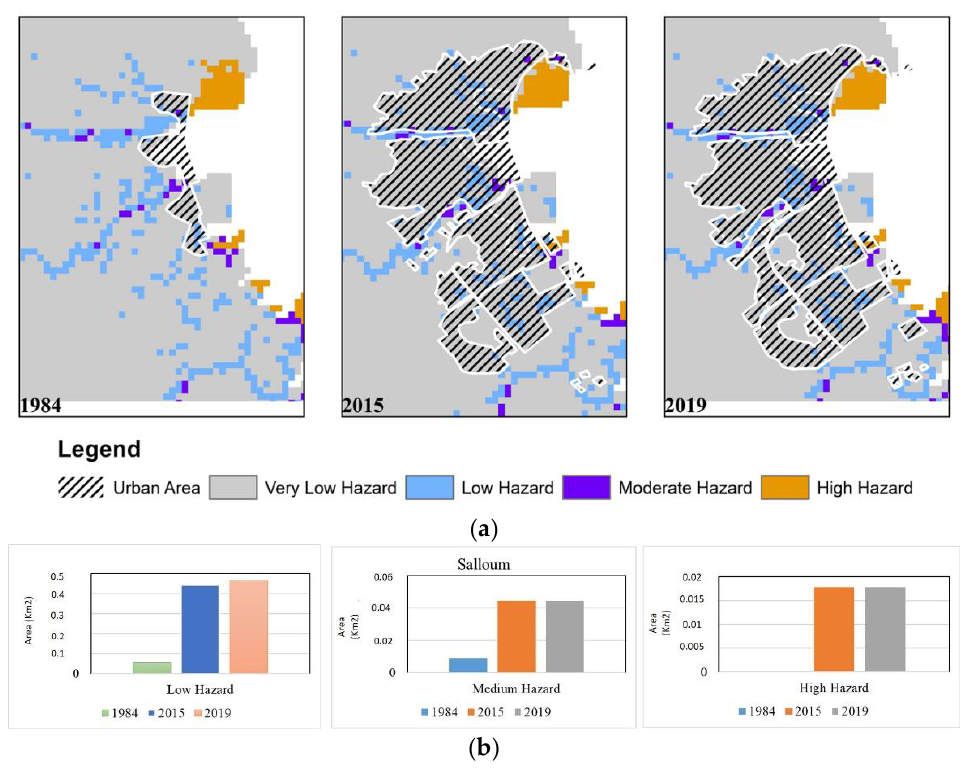
Figure 13. Inundation maps showing the hazard levels affecting the urban areas ( a ) and estimates of the vulnerable areas for flood hazard categories ( b ) over time from 1984 to 2019 in Salloum.